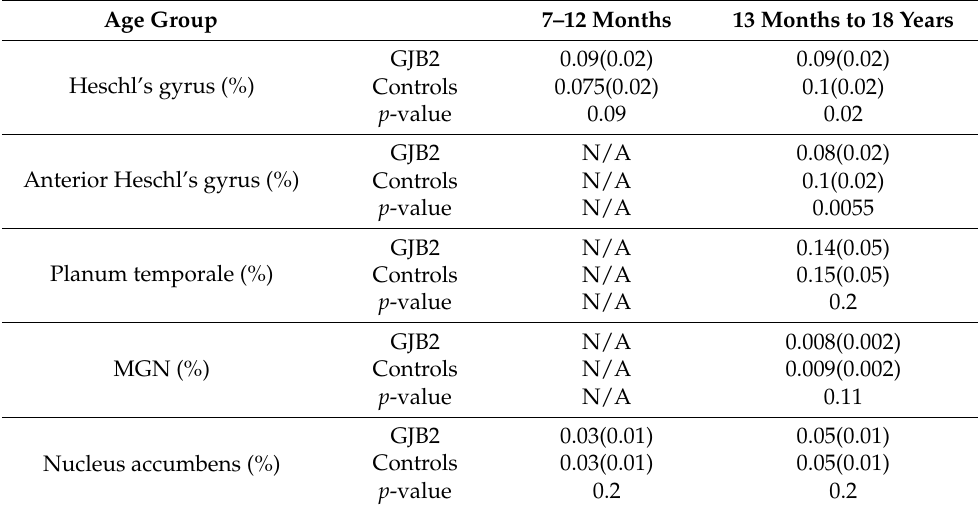
Table 2. FreeSurfer results of GJB2 patients and controls. The group-average standard deviation is reported in